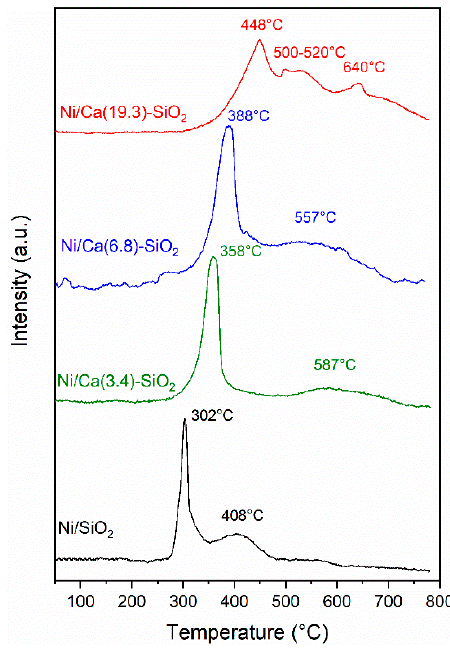
Figure 4. Temperature-programmed reduction (TPR) profiles of Ni / SiO 2 and Ni / Ca(X)-SiO 2 .